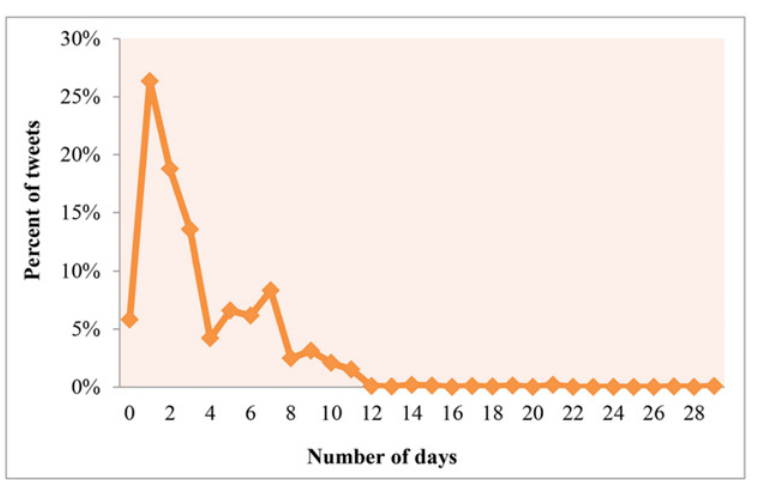
Fig 2. Distribution of Twitter response to homicide incidents in days. The distribution refers to tweets that were sent within the first month of the incident. 0 depicts the percent of tweets that were sent the same day of the homicide ’ s occurrence, 1 indicates the percent of tweets that were sent the next day,